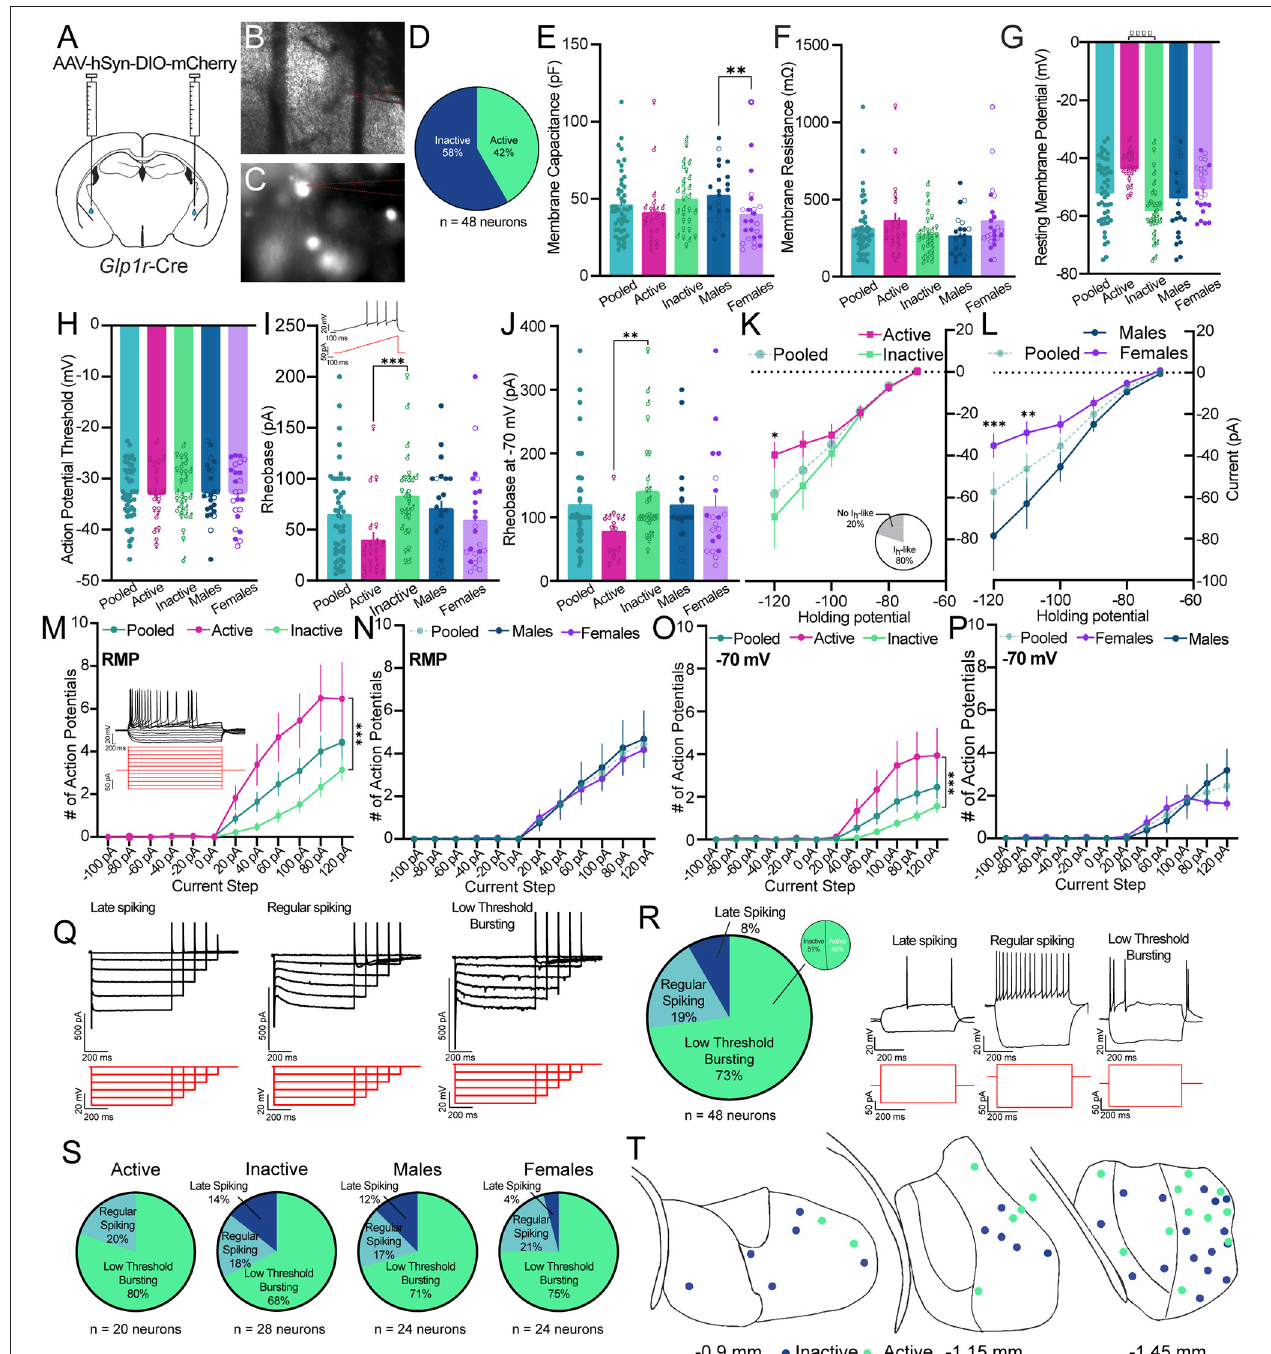
FIGURE 3 | Ex vivo patch clamp electrophysiological characterization of Glp1r CeA neurons. (A) Schematic of CeA injection of pAAV-hSyn-DIO-mCherry in Glp1r -Cre mice. (B,C) Example images of live brain slices and fluorescently labeled cells in the CeA during electrophysiological recordings from Glp1r -Cre mice. (D) Pie chart illustrating the number of Glp1r CeA neurons that were active/inactive. (E) Average membrane capacitance (Cm) of Glp1r CeA neurons in all cells (pooled) (teal), in neurons empirically determined to be active (pink) or inactive (green), or in neurons recorded from male (blue) or female (purple) mice. Within the active/inactive data sets the sex of the mouse from which the neuron was recorded is depicted by use of male and female symbols. Within the male/female data sets the activity state of the neuron is indicated by a closed (inactive) or open (active) symbol. Data were analyzed using a Mann-Whitney U test between active/inactive ( p = 0.0736) and male/female ( p = 0.0063) subgroups. (F) Average membrane resistance (Rm) of Glp1r CeA neurons in all cells (pooled) or active, inactive, male, or female subgroups. The symbol conventions used are identical to those used in (E) . Data were analyzed using a Mann-Whitney U test between active/inactive ( p = 0.2296)